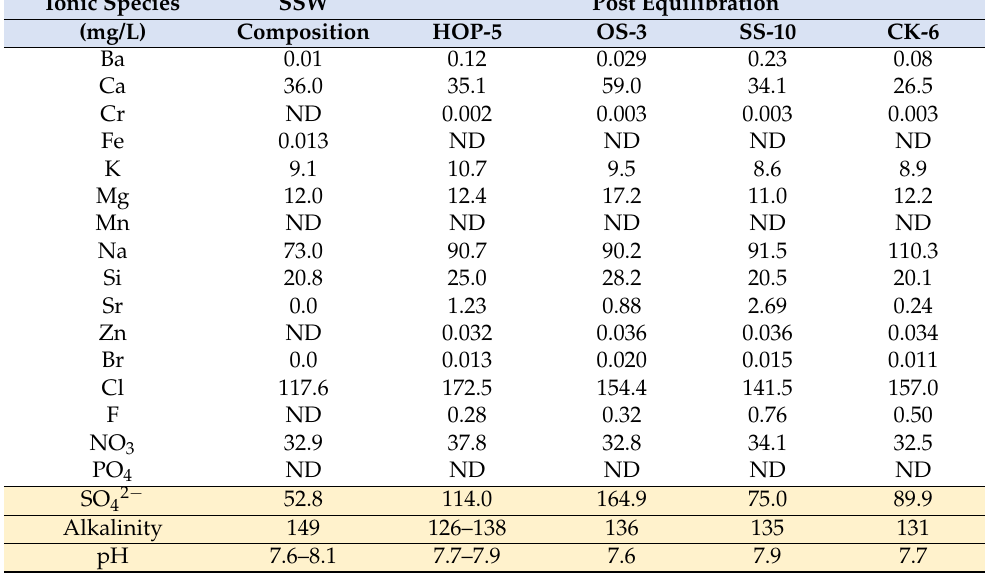
Table 1. Ionic components of the synthetic surface water (SSW) used in this study. The post- equilibration SSW chemistry is shown after equilibration of 20 mL of SSW with 2 g of crushed rock. HOP-5 is a phosphorite, OS-3 is a bituminous limestone marl, SS-10 is a sandstone, and CK-6 is an oolitic chalk. Alkalinity is represented as mg/L CaCO 3 . (ND = non-detected). Ionic Species SSW Post Equilibration (mg/L) Composition